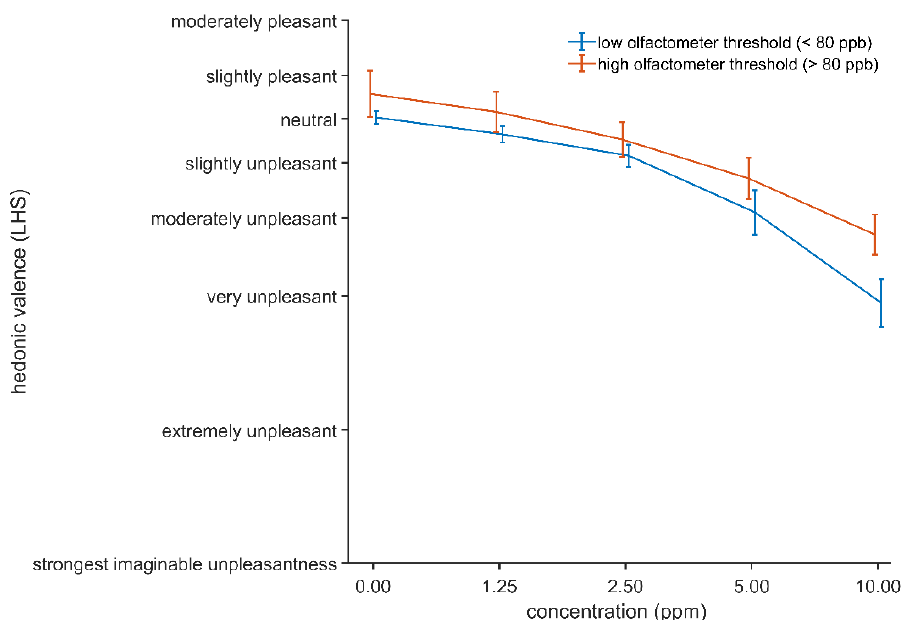
Figure 5. Effect of olfactory sensitivity assessed via the olfactometer-based threshold on pleasantness ratings during ammonia exposure (mean ± SEM).